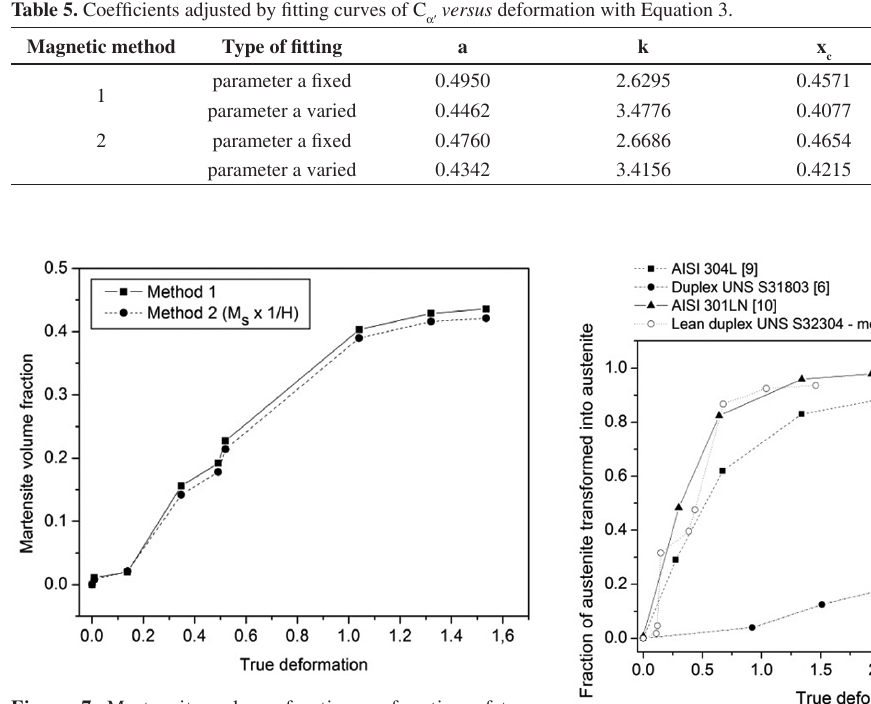
Figure 7. Martensite volume fraction as function of true deformation.